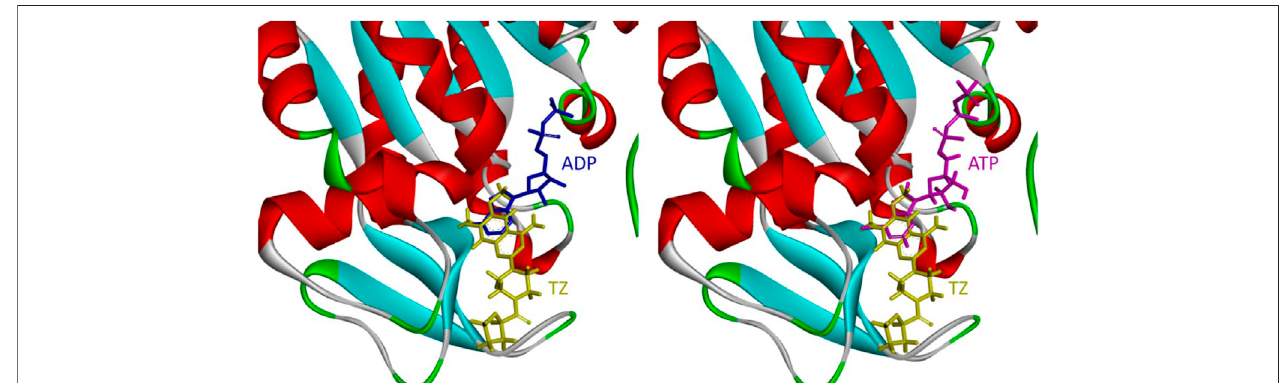
FIGURE 2 | Relative positions of TZ, ADP or ATP in the active pocket of Pgk1 (PDB ID: 2X15).